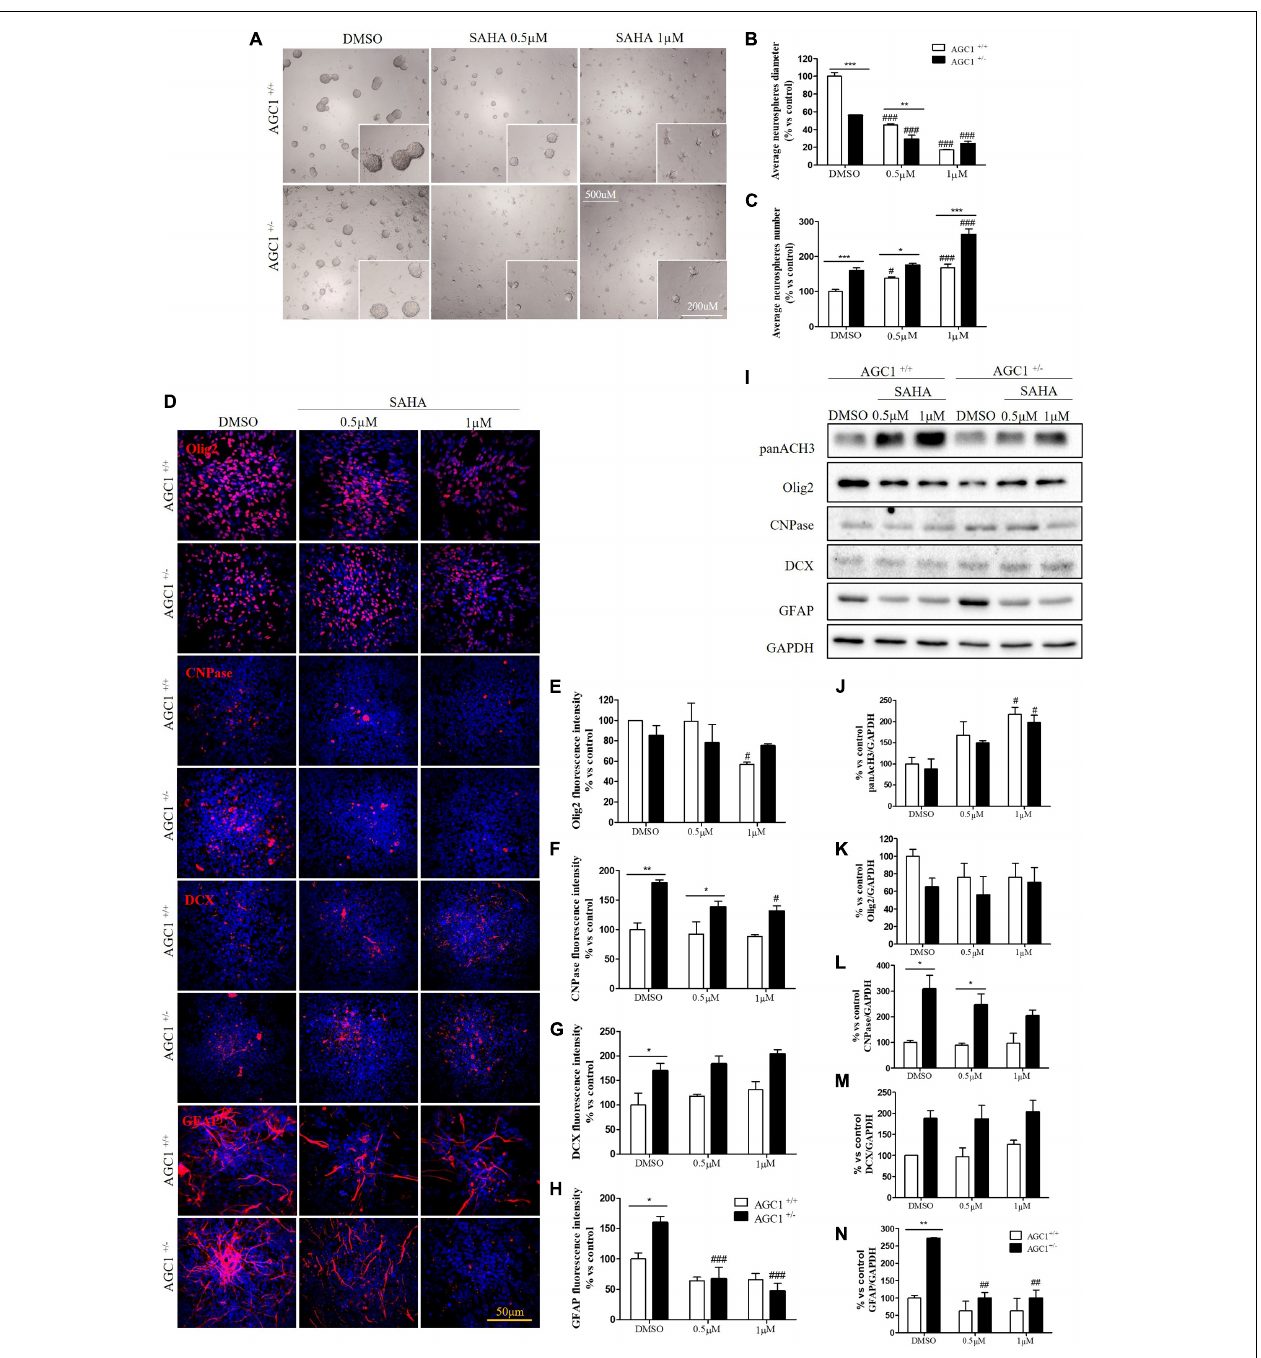
FIGURE 11 | Suberanilohydroxamic acid-mediated HDACs inhibition affects proliferation and commitment through glial cells in spontaneously differentiated AGC1 + / + and AGC1 ± neurospheres. Optical microscope images (A) and counting of number (B) and diameter (C) of neurospheres after 7 days of culture in presence of SAHA 0.5 and 1 µ M. Average number and size were measured with Fuji Imagej2 software using an automated colony and cell counting method; only aggregates bigger than 400 µ m 2 were considered. Values are mean ± SD of 5 different fields acquired for each condition. 10X objective; 500 and 200 µ m bar scale. Immunofluorescence staining and cell counting of Olig2 (D,E) , CNPase (D,F) , DCX (D,G) , and GFAP (D,H) on AGC1 + / + and AGC1 ± 7DIV spontaneously differentiated neurospheres following HDACs inhibition with SAHA 0.5 and 1 µ M. Values are mean ± SD of 3 different fields acquired for each condition. 60X objective; 50 µ m bar scale. WB and relative densitometries of panAcH3 (I,J) , Olig2 (I,K) , CNPase (I,L) , DCX (I,M) , and GFAP (I,N) expression in AGC1 + / + and AGC1 ± differentiated neurospheres following HDAC inhibition with SAHA 0.5 and 1 µ M. Values are mean ± D of 3 independent experiments. # p < 0.05, ## p < 0.01, ### p < 0.001, compared to DMSO control, respectively; * p < 0.05, ** p < 0.01, *** p < 0.001, compared to each treated control; two-way ANOVA (Bonferroni’s post hoc test).